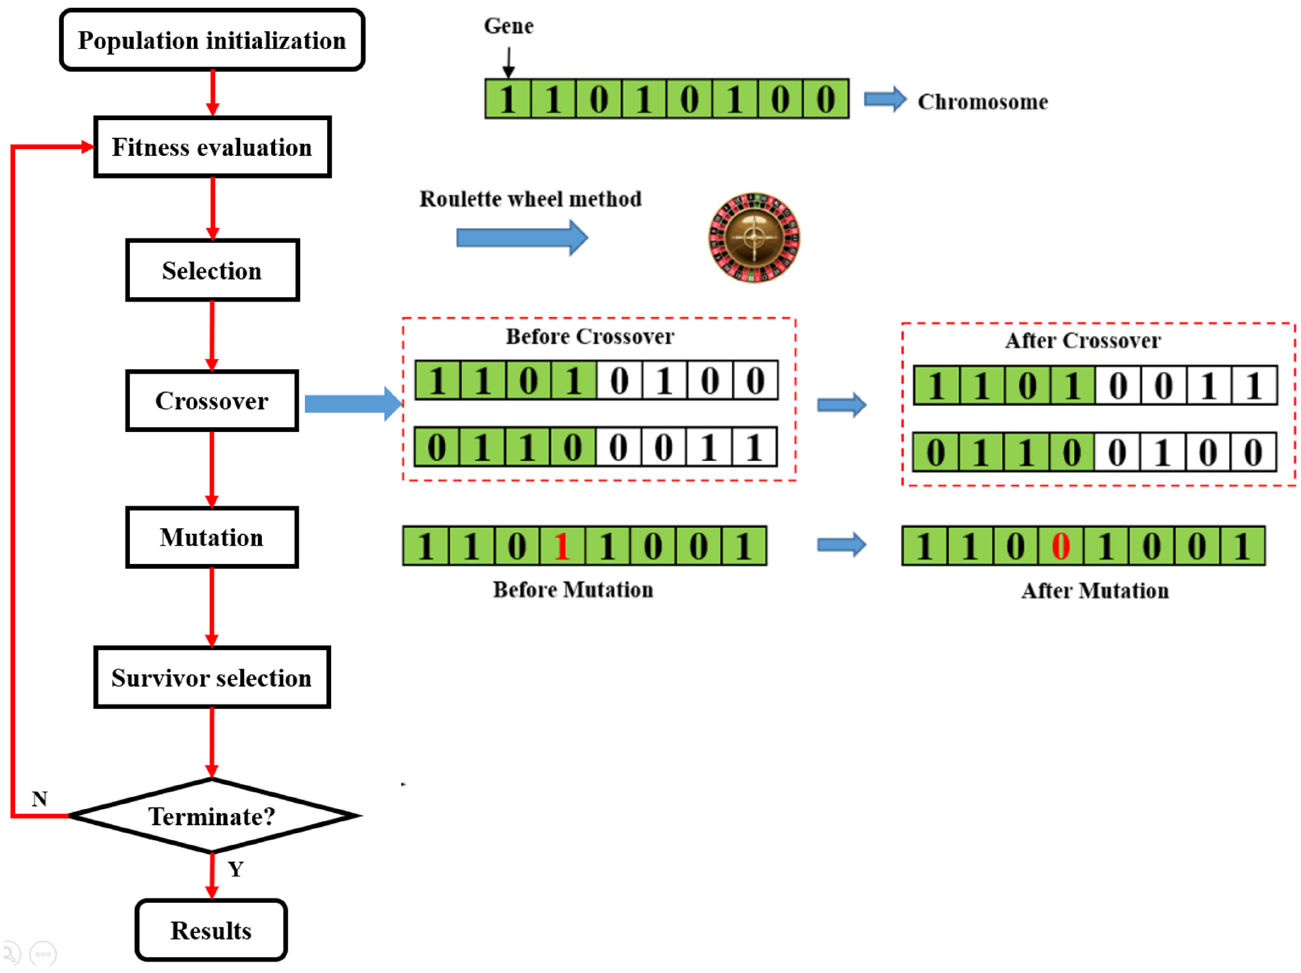
Figure 9. Flowchart of the genetic